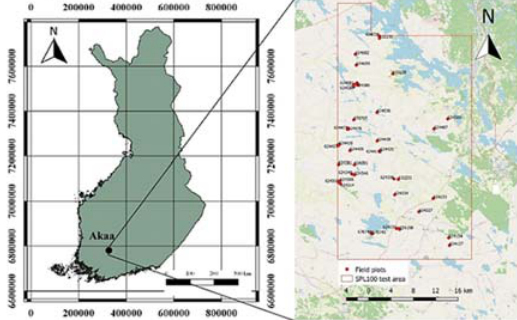
Figure 1. Study area with 49 field sample plots visualized over OpenStreetMap-layer.